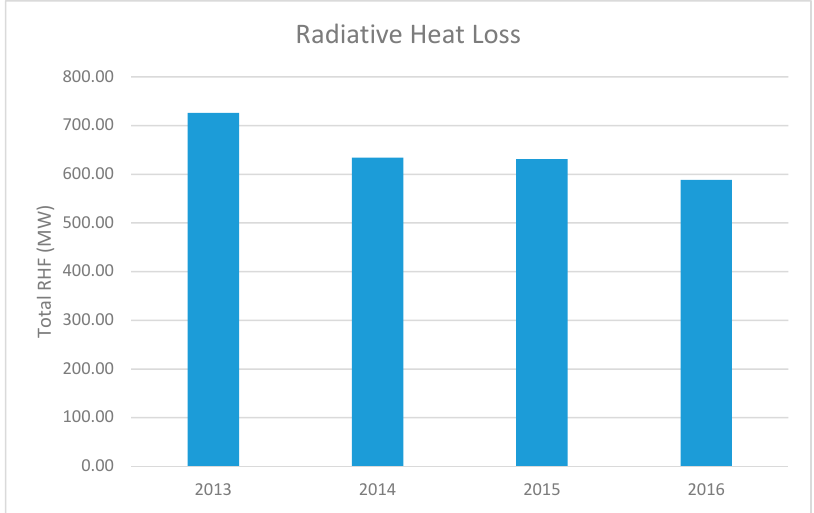
Figure 7. The changes of radiative heat loss (RHL) of the study area from 2013 to 2016.